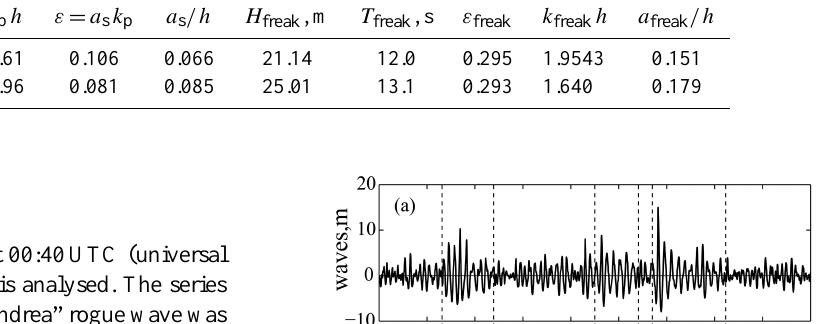
Table 1. Parameters characterizing the nonlinearity of the series and of the individual freak waves. Quantity H s , m k p h ε = a s k p a s /h H freak , m T freak , s ε freak k freak h